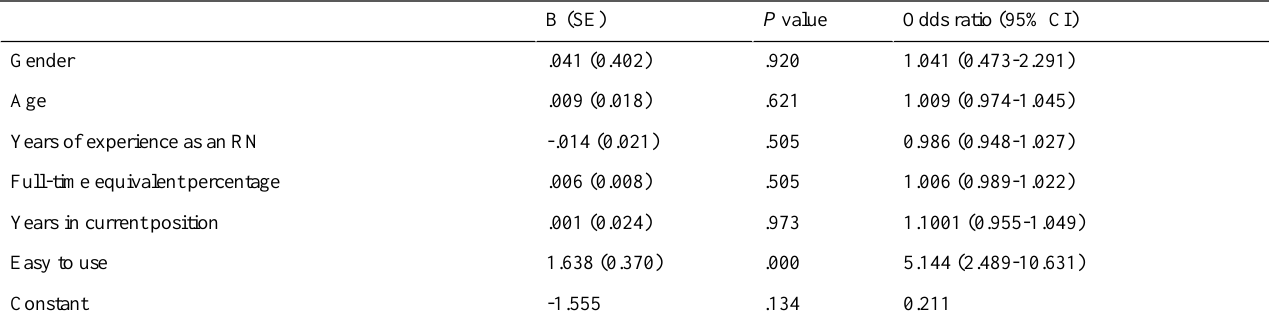
Table 3. Logistic regression model examining predictors affecting the assessment of e-messaging as a useful tool (N=391).